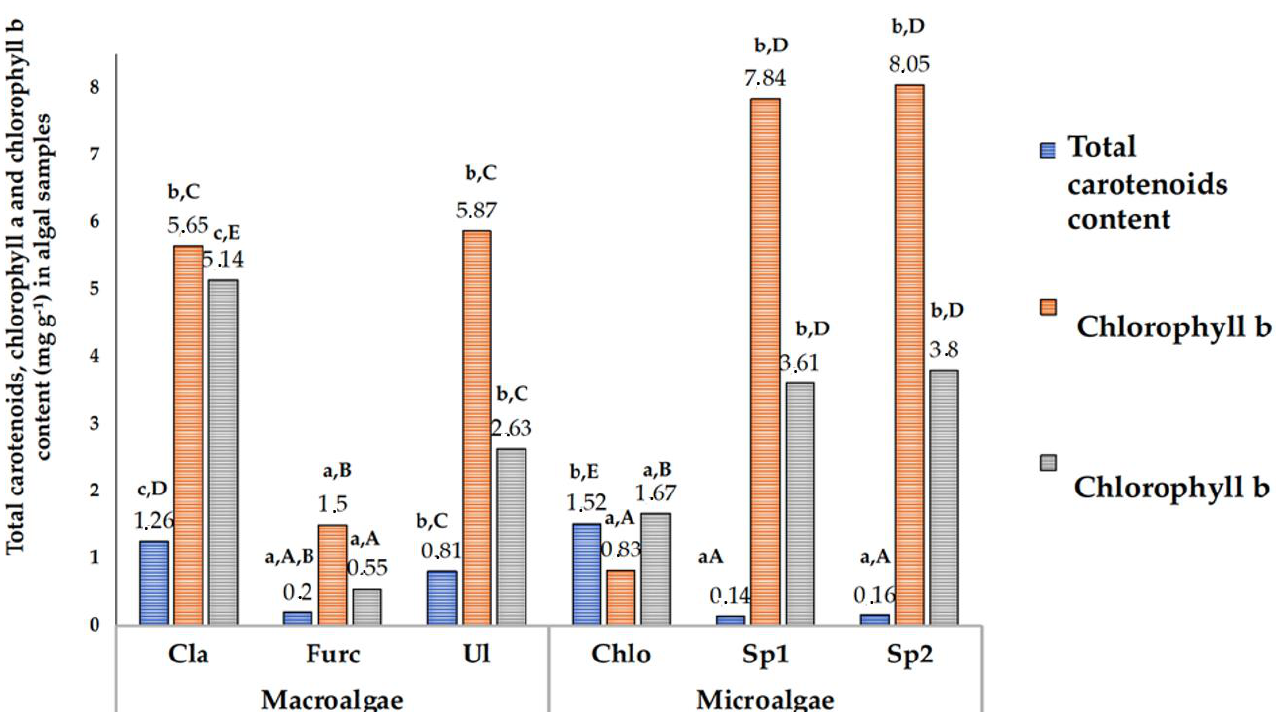
Figure 2. Total carotene, chlorophyll a, and chlorophyll b content (mg g −1 ) in algal samples ( Cla, Cladophora rupestris ; Furc, Furcellaria lumbricalis ; Ul, Ulva intestinalis ; Chlo, Chlorella vulgaris ; Sp1, Spirulina ( Arthrospira platensis ) from University of Texas; Sp2, Spirulina (Ltd. „Spila“). a–c for the same analytical parameters, in macro- and microalgae groups, means with different letters are significantly different ( p ≤ 0.05). A–E for the same analytical parameters, in all algal samples, means with different letters are significantly different ( p ≤ 0.05)).